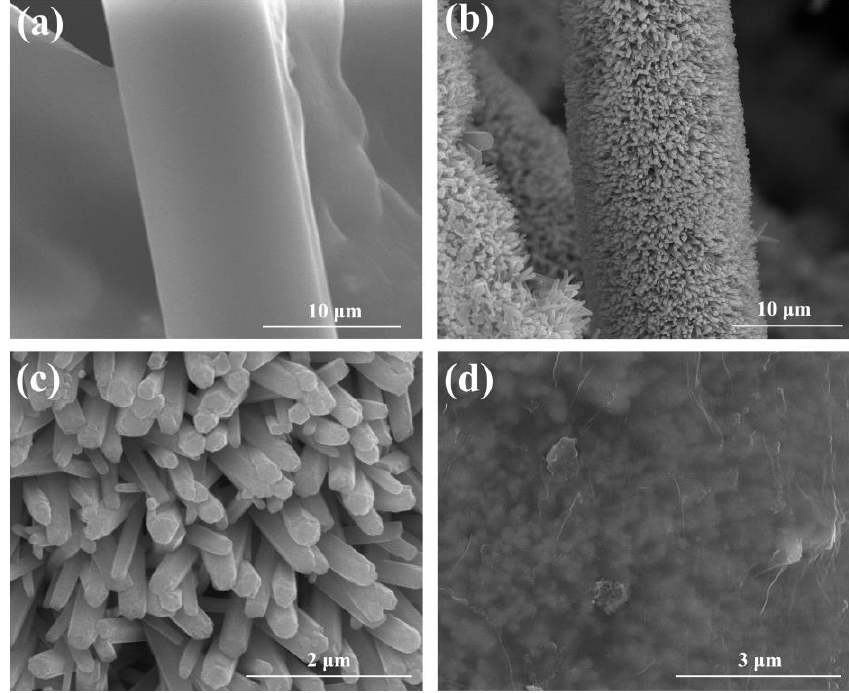
Figure 1. SEM images of the obtained materials. ( a ) PET fabric, ( b ) PET/ZnO composite fabric, ( c ) magnified image of the PET/ZnO composite fabric, and ( d ) PET/ZnO@MXene composite fabric. The structures of the PET, PET/ZnO, and PET/ZnO@MXene composite fabrics